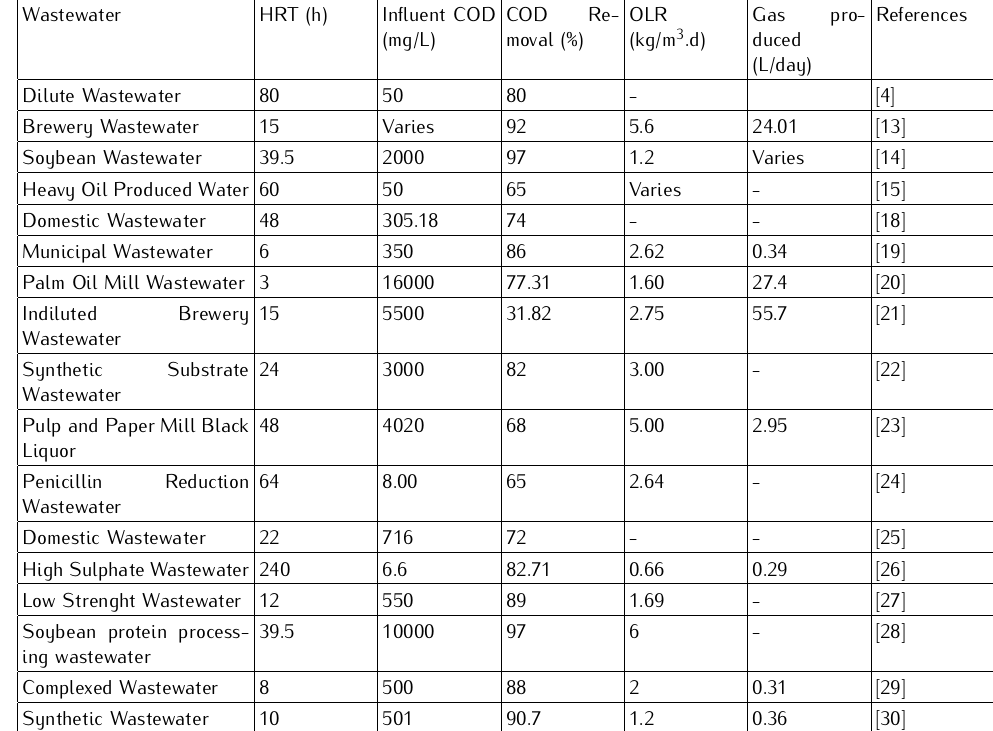
Table 1. Summary of performance